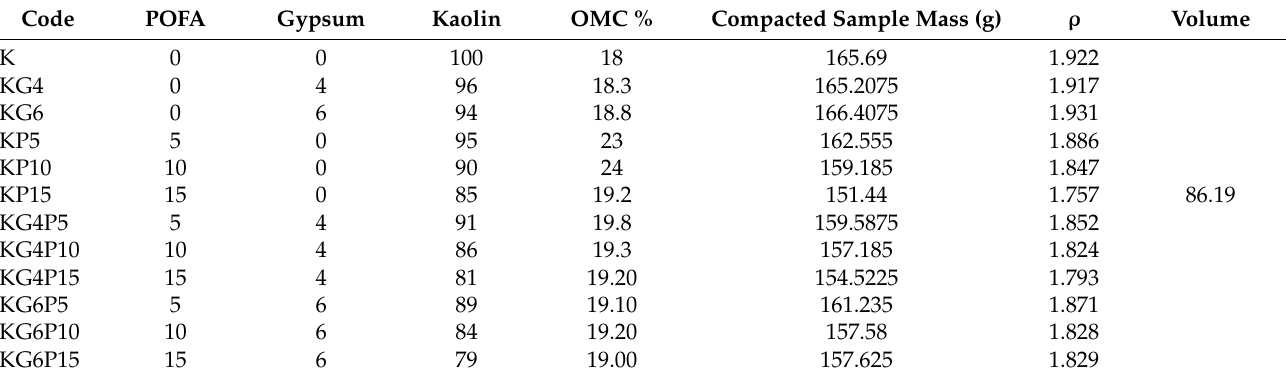
Table 2. Precentages of the utilized stabilizing agents with mass, density and